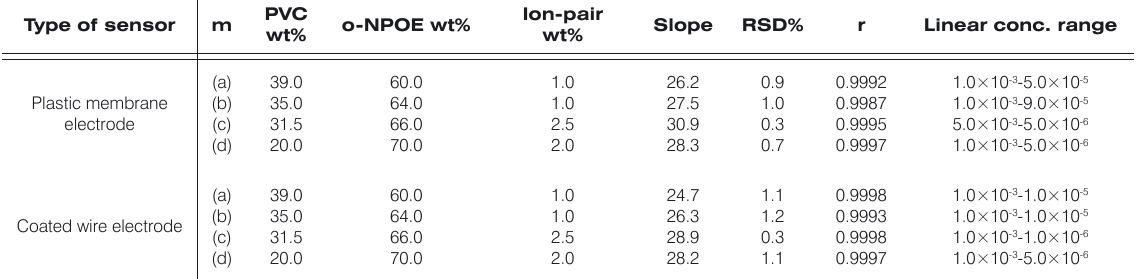
Table 2. Critical response characteristics of phenytoin-tungstosilicate sensors.